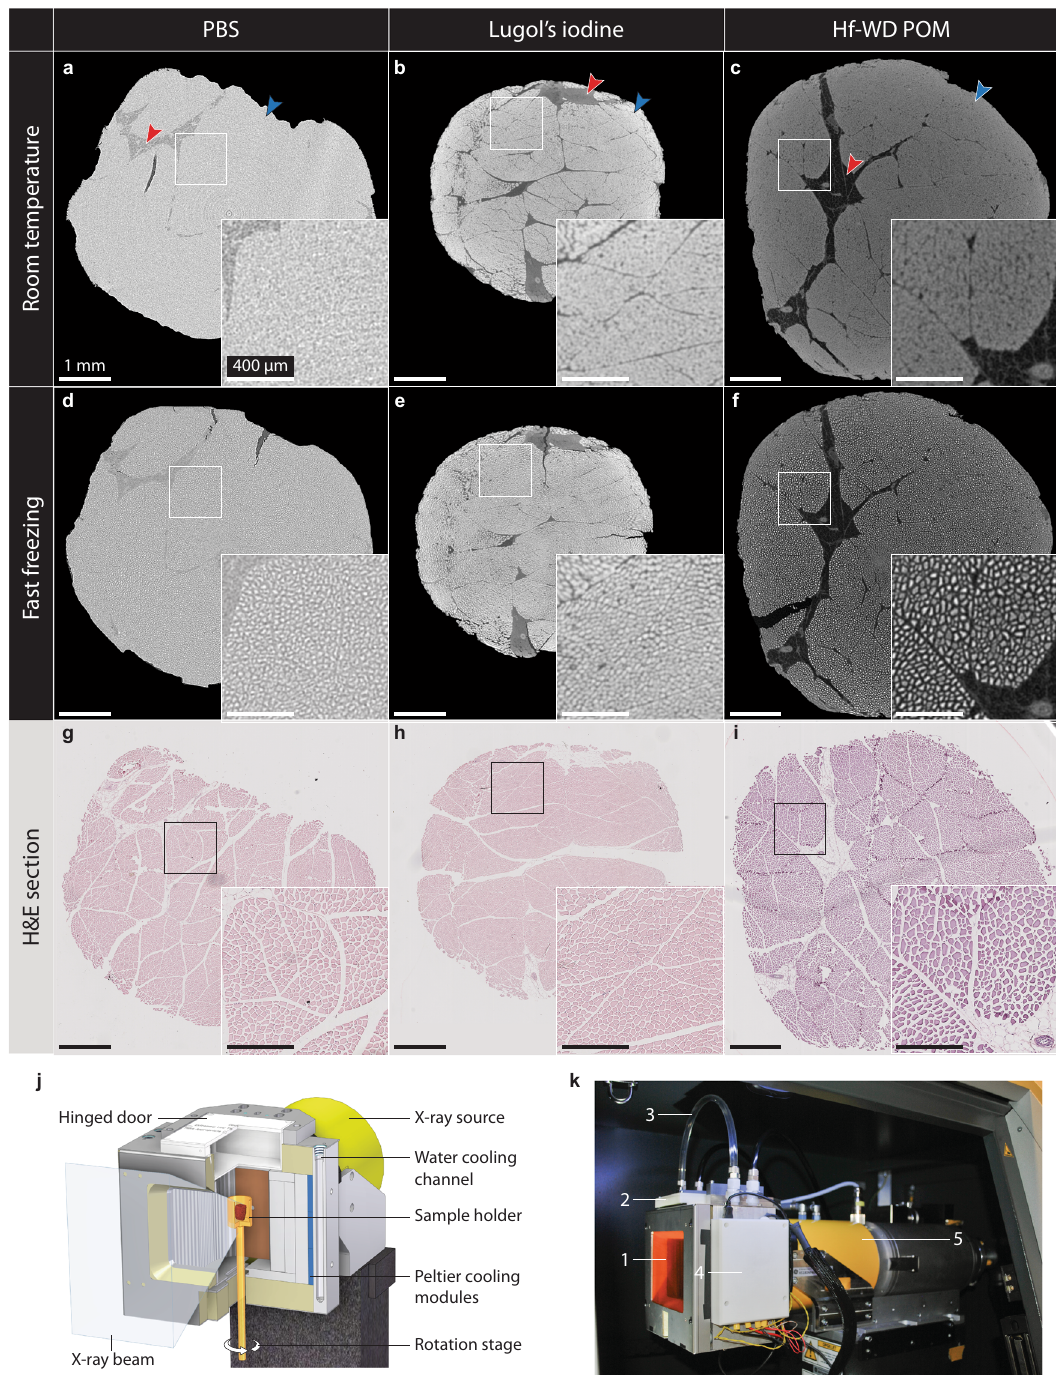
Fig. 1 | The effect of freezing and different CESAs on the microstructure of bovine muscle tissue as visualized by CECT and cryo-(CE)CT. a – c Conventional (CE)CT images of bovine muscle tissue acquired at room temperature without staining ( a ), stained with Lugol ’ s iodine ( b ) and stained with Hf-WD POM ( c ). The muscle tissue (blue arrow) and the intermuscular fat (red arrow) can be dis- tinguished.Histogramswerewindowedbasedontheirdynamicrange.Hence,gray valueswerenotnormalized in-betweendifferentdatasets. d – f Cryo-(CE)CTimages after freezing the tissues by submersion in isopentane at − 78°C (fast freezing). Individual muscle fi bers (bright) surrounded by the fascicular matrix (dark) are